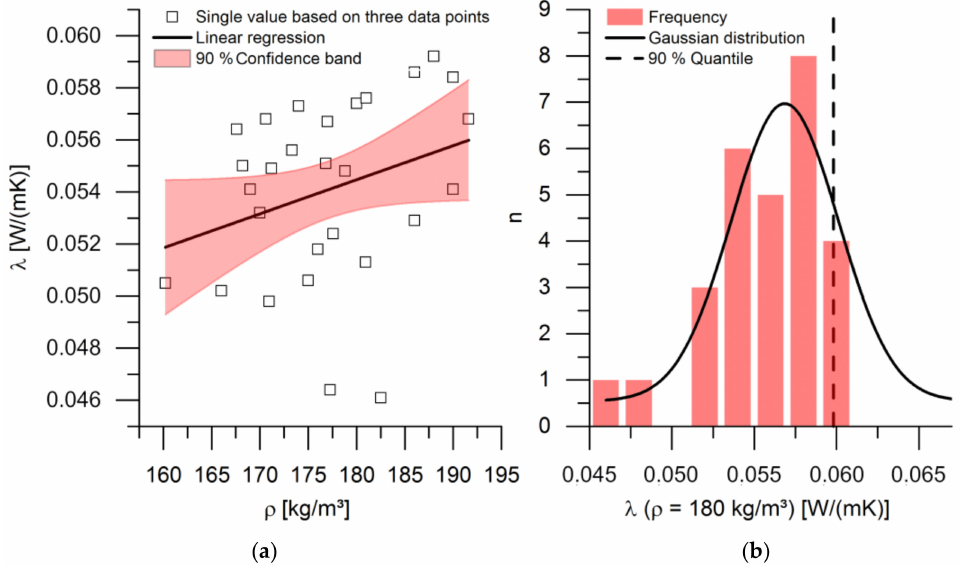
Figure 7. ( a ) Measured thermal conductivities (average sample temperature at 10 ◦ C) vs. the density of dried cementitious foams; ( b ) normal distribution of the parallel shifted values along the regression